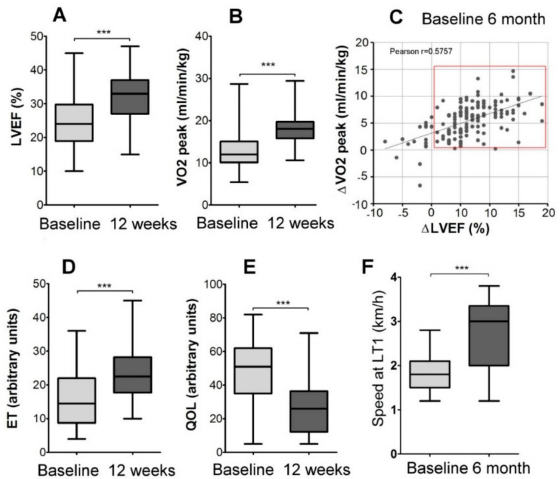
Figure 2. The e ff ects of personalized training on patients’ functional capacity: ( A ) Left ventricular ejection fraction (LVEF) increased significantly after 6 months of personalized training program (*** p < 0.0001; n = 144); ( B ) oxygen uptake (VO2) peak substantially increased after 12 weeks of personalized training program while VO2 at lactate threshold remained unchanged (*** p < 0.0001; n = 144); ( C ) the plot of VO2 peak changes versus changes in LVEF after 12 week training course indicates that most of the patients in the group demonstrated an improvement in both parameters (red